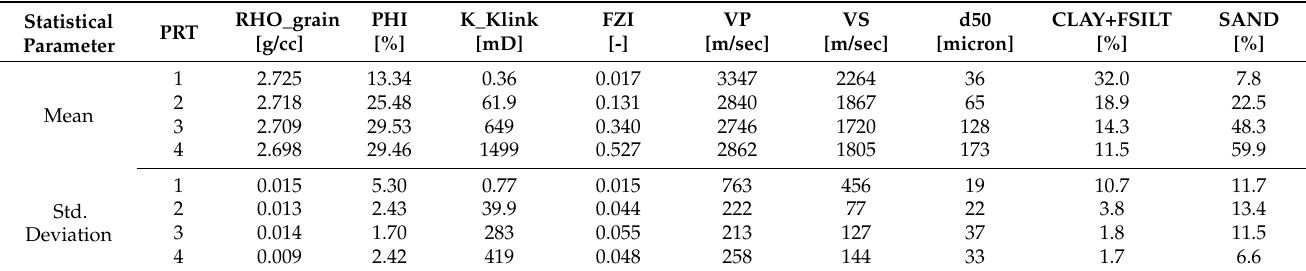
Table 4. Descriptive statistical values of each identified petrophysical rock type (PRT). The analysed parameters are defined in Table